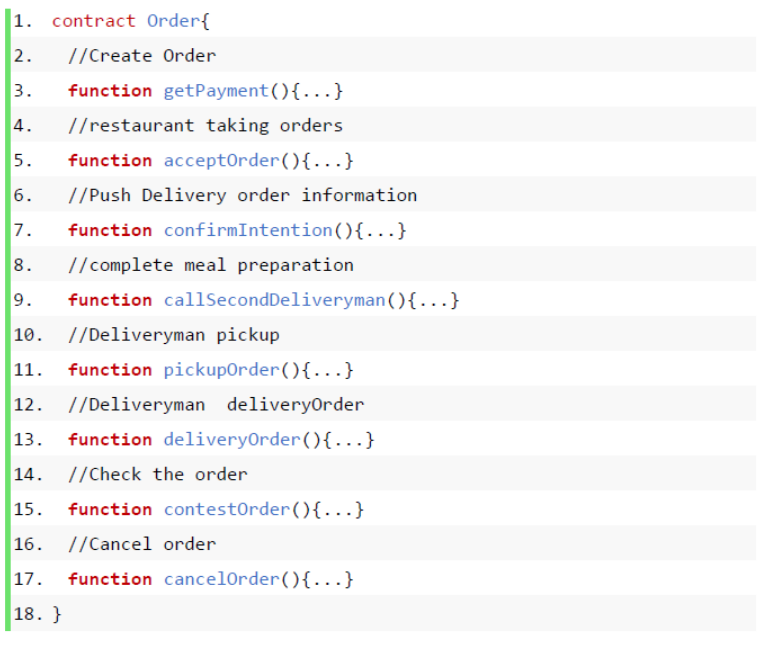
Figure 13. Order contract function implementation.